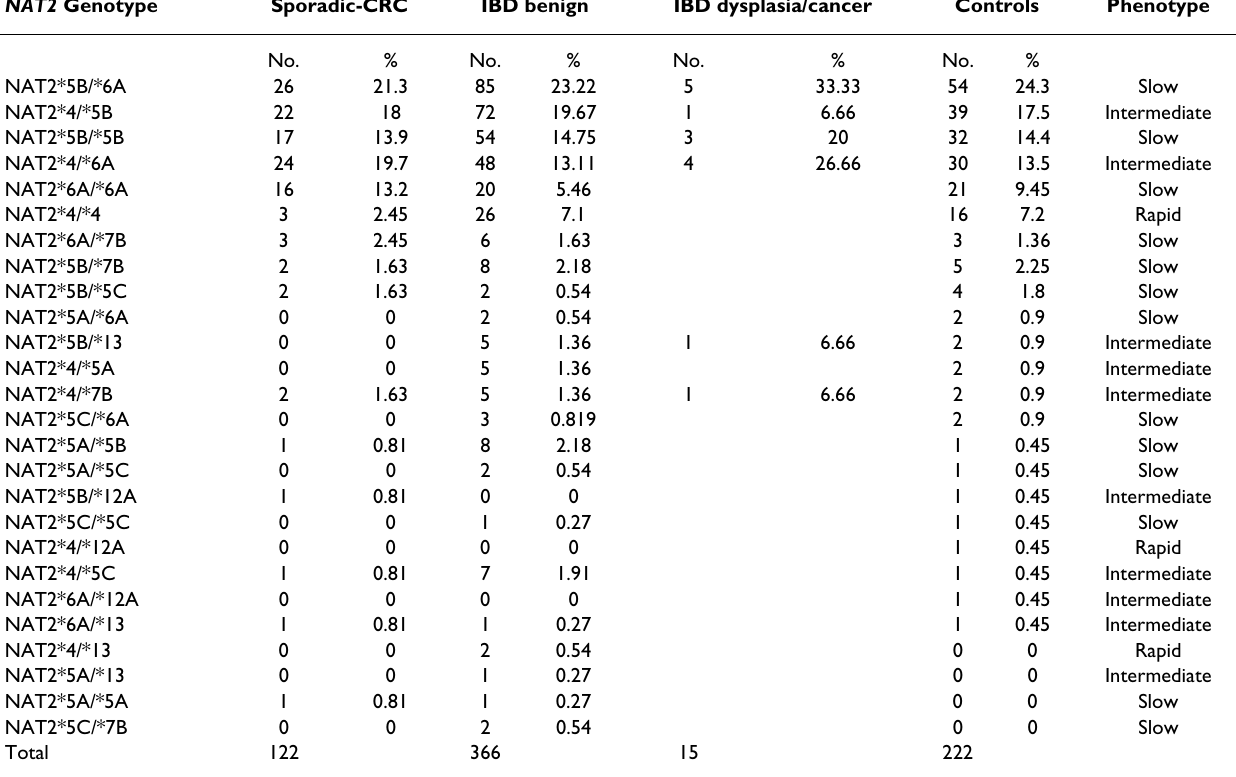
Table 3: NAT2 genotype frequency. NAT2 Genotype